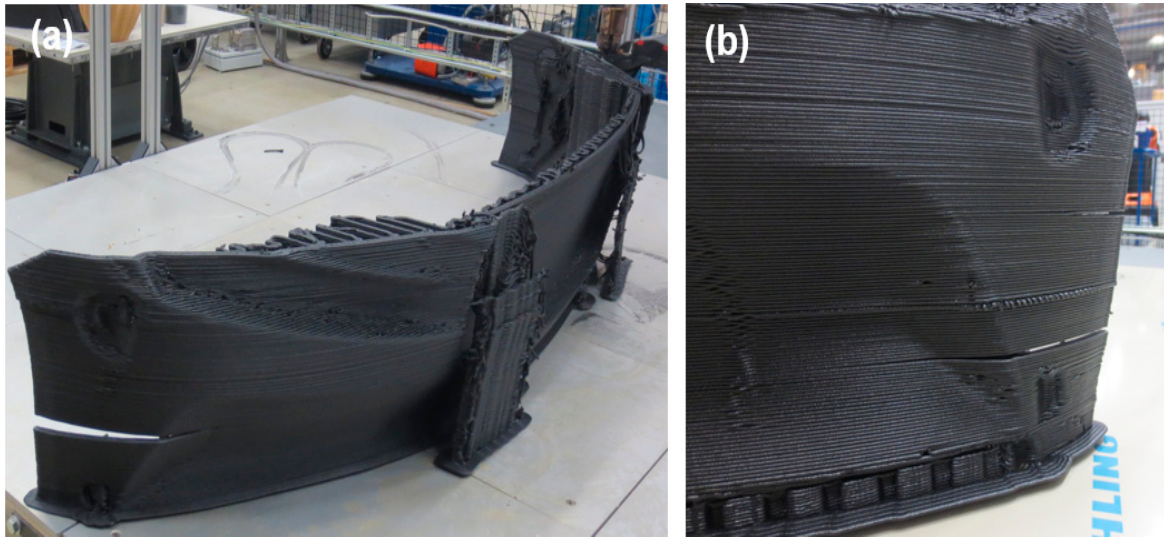
Figure 3. (a ) Cracking and delamination in a vehicle bumper printed from ABS+15%GF. ( b ) Enlarged view of cracking locations.